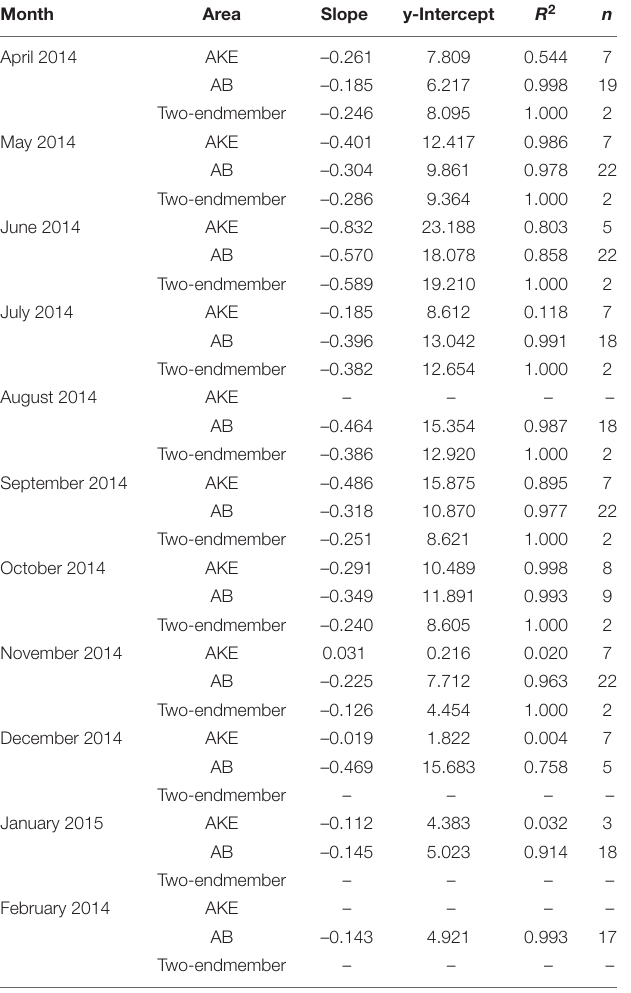
TABLE 2 | Results of linear regression analysis between salinity and a CDOM (355) in AKE and AB and for two-end-members between freshwater (RB) and coastal water based on salinity.